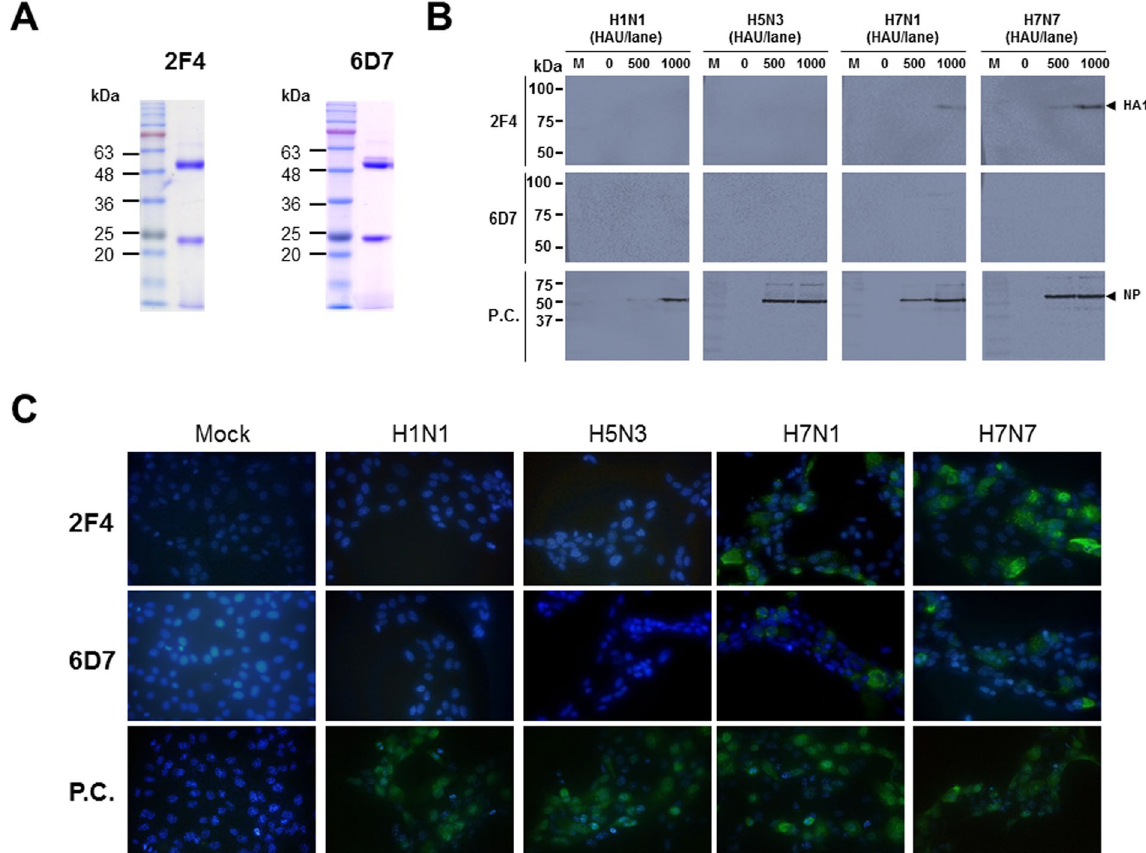
Figure 3. Characterization of H7 subtype-specific antibodies. Both 2F4 and 6D7 antibodies were produced in ascites and purified by Protein G and SDS-PAGE was conducted to identify the heavy - and light chain of each antibody ( A ). Four influenza A subtype viruses were loaded on a SDS-PAGE gel and Western blotting was used to analyze each antibody ( B ). In the immunofluorescence assay, cells were independently infected with the virus subtypes for 12 h, and the cells were fixed and incubated with 2F4 and 6D7 antibodies. After washing, fluorescence was detected by a FITC-conjugated secondary antibody ( C ). M, marker; Mock, no virus